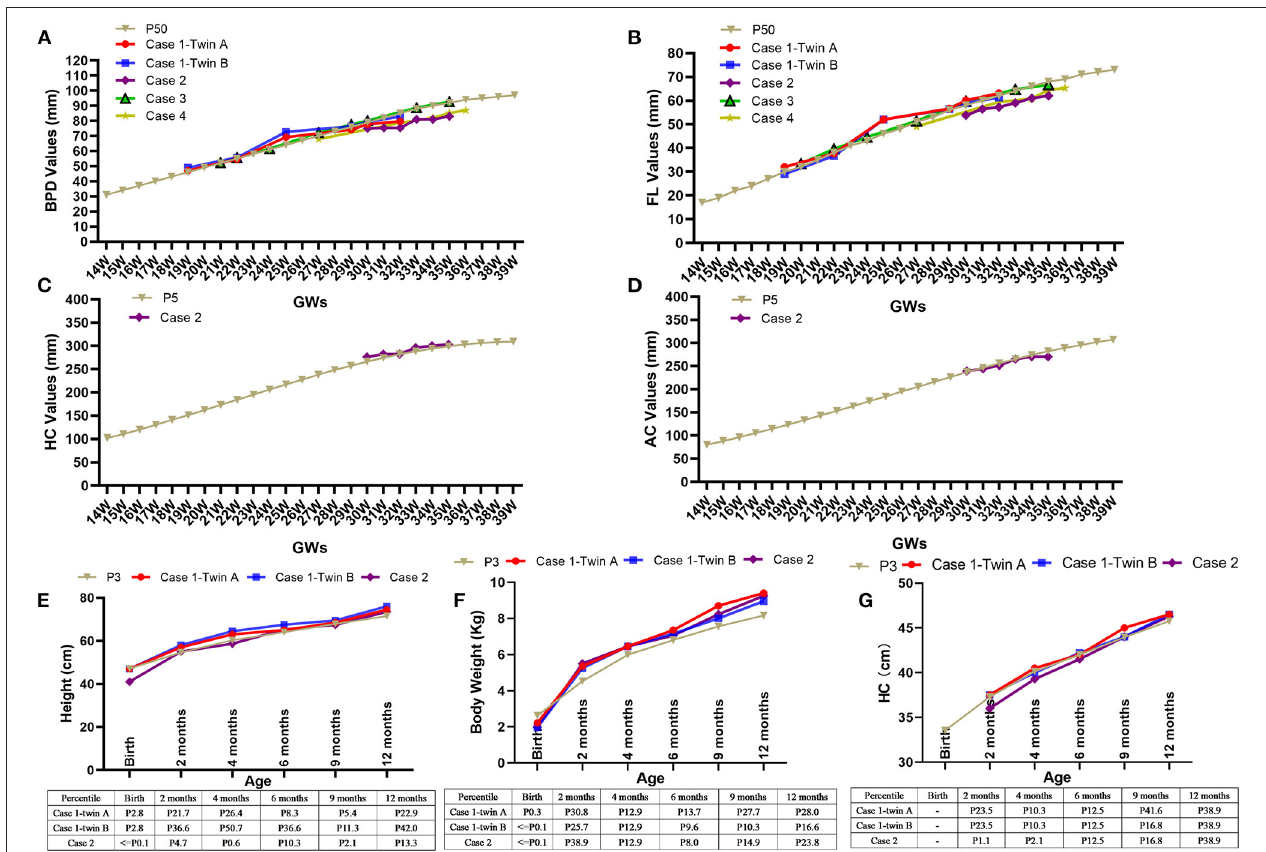
FIGURE 3 | Adverse effects of dexamethasone on fetal growth and Catch-up growths during the first year of life. The fetal biparietal diameters (BPD) and femur lengths (FL) were ∼ 50th percentile after the initiation of dexamethasone, as shown in five fetuses (A,B) . The changes in head circumference (HC) (C) and abdominal circumference (AC) (D) of the fetus in case 2 were ∼ 5th percentile. The heights (E) , weights (F) , and head circumference (HC) (G) of the three infants in case 1 and case 2 during their monthly follow-up visits gradually increased and even exceeded the 3rd percentile via postnatally catch-up growth. GWs, gestational weeks; Kg, kilogram; cm,